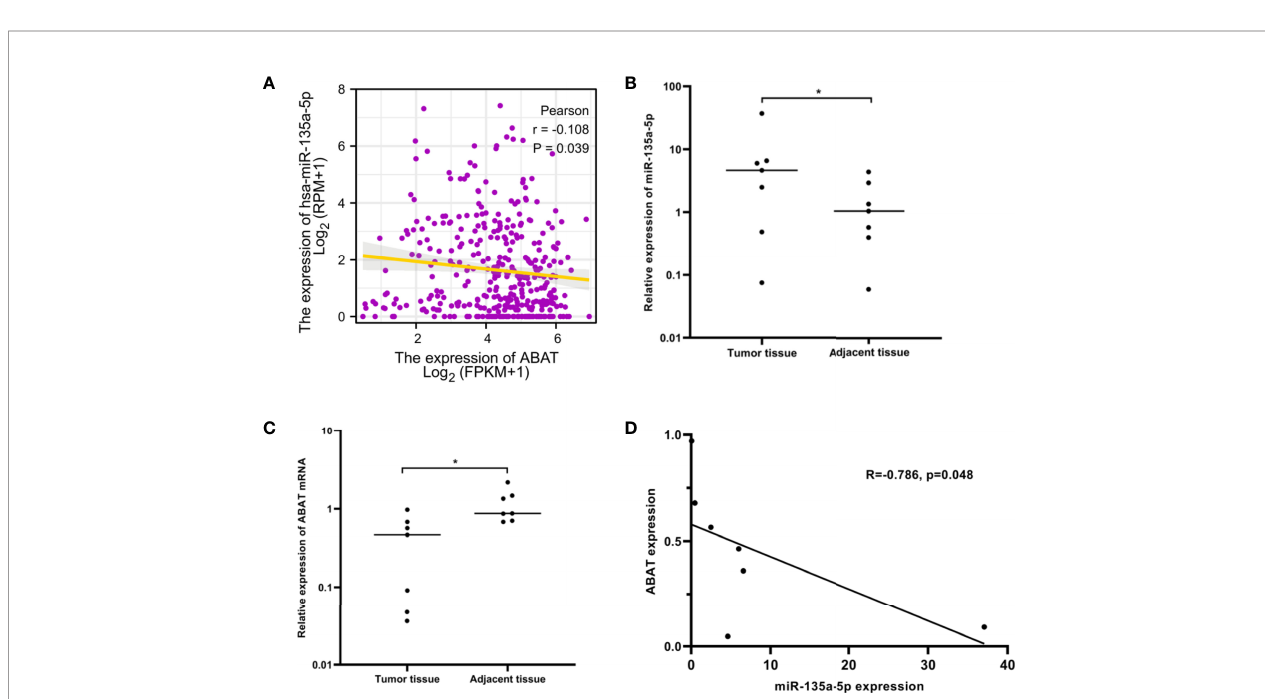
FIGURE 9 | miR-135a-5p expression and its correlation with ABAT in HCC. (A) The correlation between miR-135a-5p and ABAT was analyzed with TCGA data. (B) qRT-PCR for detection of miR-135a-5p in seven paired HCC and adjacent tissues. (C) qRT-PCR for detection of ABAT in seven paired HCC and adjacent tissues. (D) The correlation between miR-135a-5p and ABAT with qRT-PCR data. *P <